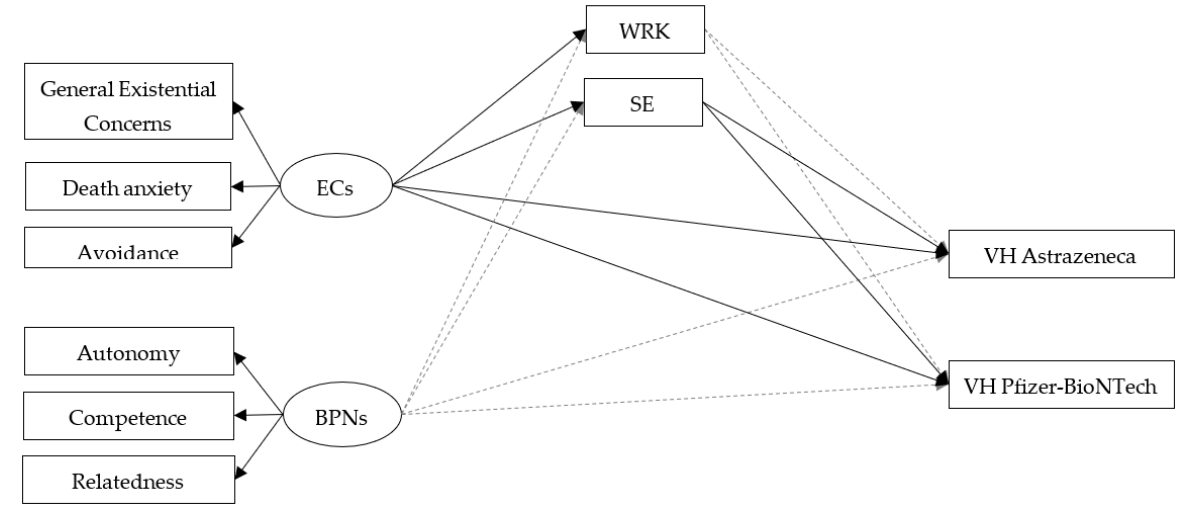
Figure 2. Structural equation modeling testing attitudes towards COVID-19 vaccines as a mediator of the relationship among ECs, BPNs and Pfizer-BioNTech and AstraZeneca VH. Note. ECs = Existential Concerns; BPNs = Basic Psychological Needs; WRK = Attitude toward COVID-19 vaccines—vaccine will be effective; SE = Attitude toward COVID-19 vaccines—side effects; VH = Vaccine Hesitancy; Errors and correlations were omitted from the diagram for clarity; Non-significant paths are represented by grey dashed lines; Significant paths are represented by black solid lines.